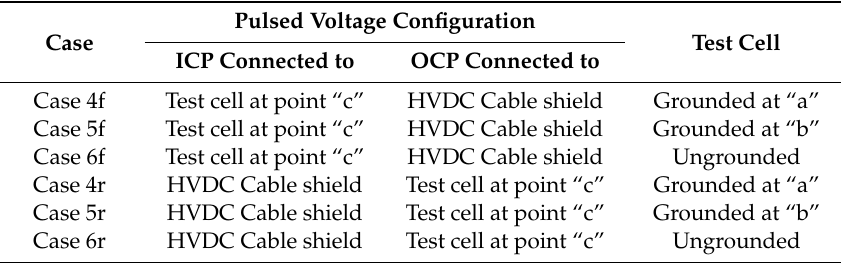
Table 3. Influence of PEA test cell grounding